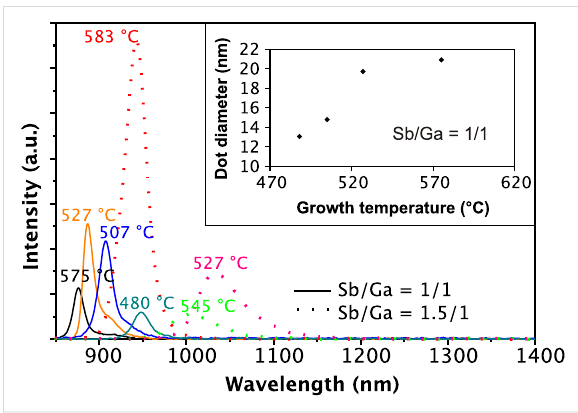
Figure 4: PL spectra of dots grown with a V/III ratio of 1/1 and 1.5/1, but at different growth temperatures. The PL measurements were performed at a constant sample temperature of T PL = 20 K. Inset: Dot diameter plotted against growth temperature for samples with a V/III ratio of 1/1.